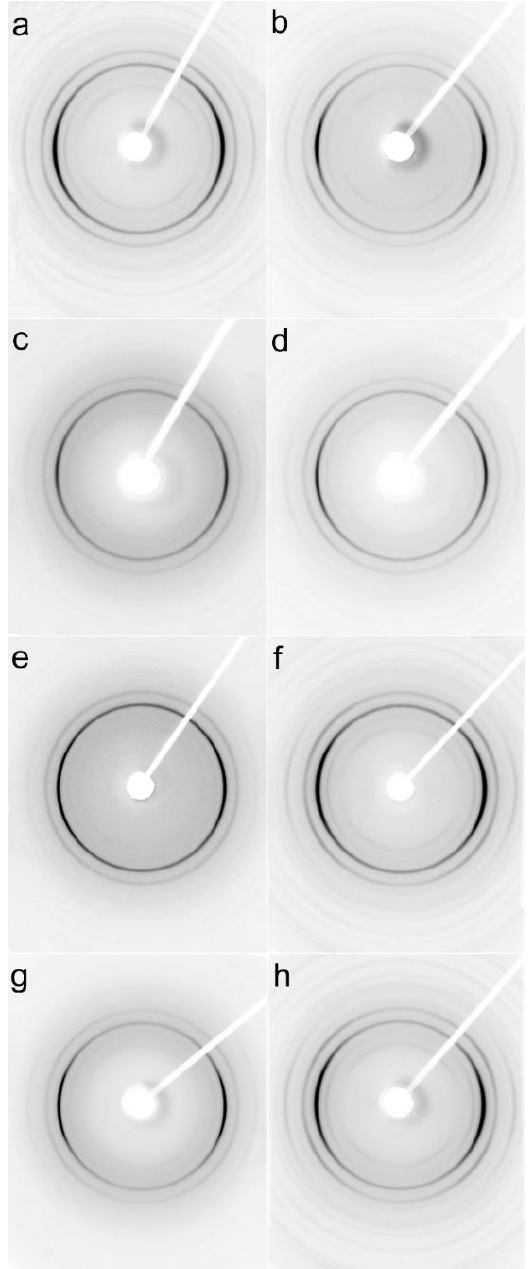
Figure 7. 2D-WAXS patterns of PLLAs: L339 sheared at 170 °C at 5 /s for 20 s ( a ) and at 20 /s for 5 s ( b ) and cooled at 10 °C/min, 4S123 sheared at 150 °C at 10 /s for 10 s ( c ) and at 20 /s for 5 s ( d ) cooled at 30 °C/min, L240 sheared at 150 °C at 10 /s for 10 s ( e ) and at 20 /s for 5 s ( f ) cooled at 30 °C/min, 6S245 sheared at 150 °C at 10 /s for 10 s ( g ) and at 20 /s for 5 s ( h ) cooled at 30 °C/min. Shearing direction -vertical.